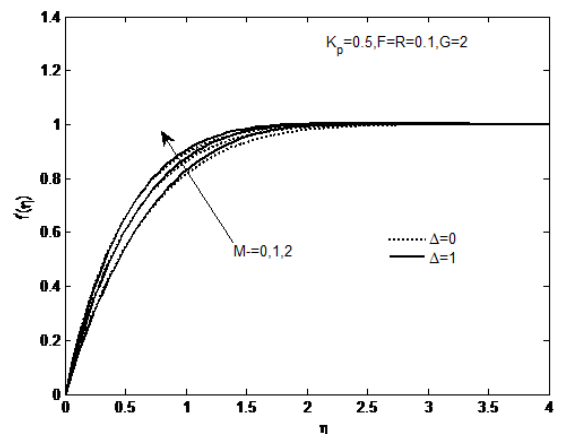
Fig. 2: Velocity profile for different values of M and